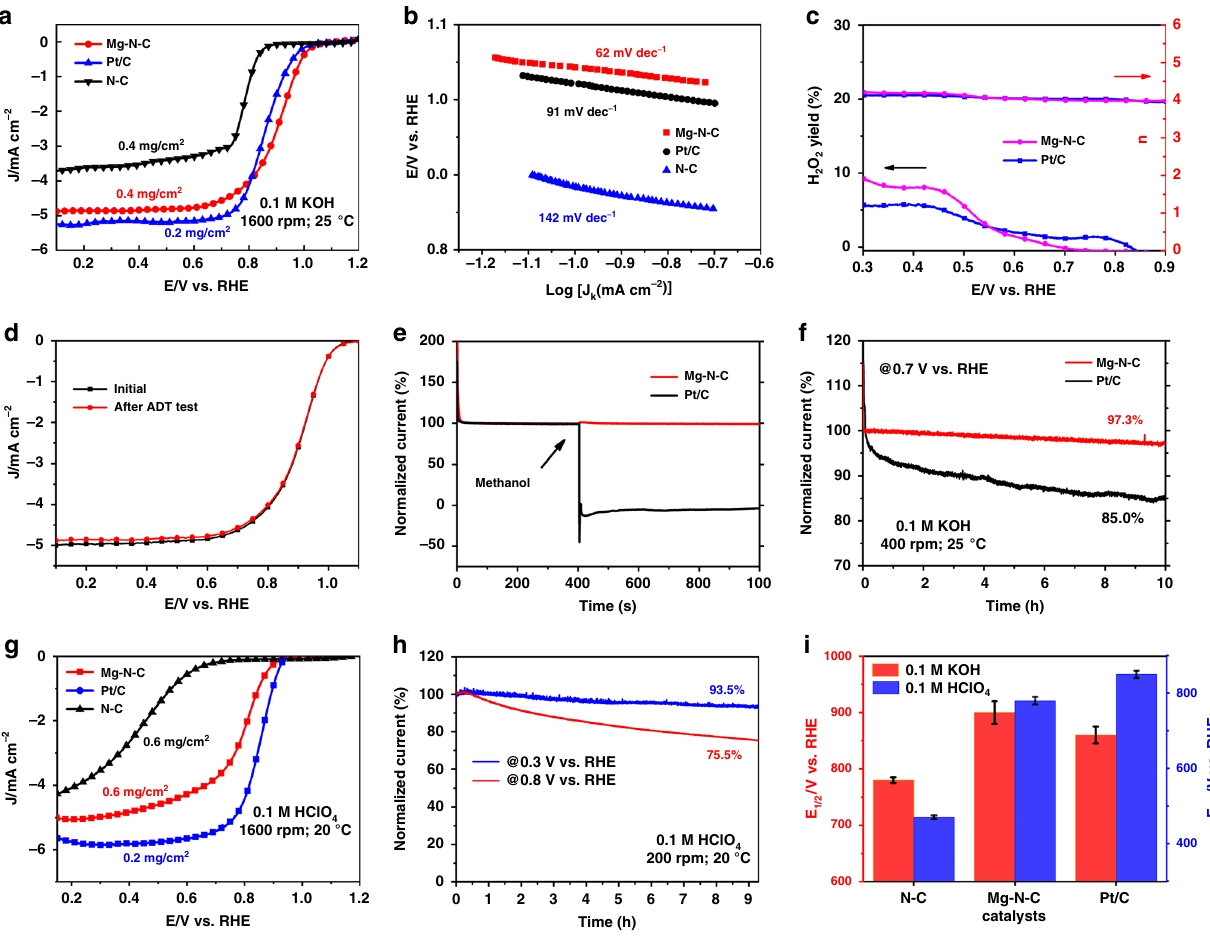
Fig. 4 Performance of Mg – N – C as an oxygen reduction reaction catalyst. a LSV curves after normalization by glass carbon (GC) electrode in O 2 - saturated 0.1 M aqueous KOH electrolyte solutions at a sweep rate of 5 mV s − 1 . b Tafel slope of the catalysts in 0.1 M KOH solution. c The H 2 O 2 yield and the electrons transfer rate of the catalysts in 0.1 M KOH solution. d Mg – N – C before and after accelerated durability test (ADT) with 5000 cycles from 0.8 to 1.1 V (vs. RHE) at a sweep rate of 100 mV s − 1 . e Methanol tolerance test of Mg – N – C at 0.8 V (vs. RHE) with 1600 rpm in O 2 -saturated 0.1 M KOH solution. 4 ml methanol is injected into 110 ml O 2 -saturated 0.1 M KOH solution at 400s. f CA test of the catalysts at 0.7 V (vs. RHE) with 400 rpm for 10